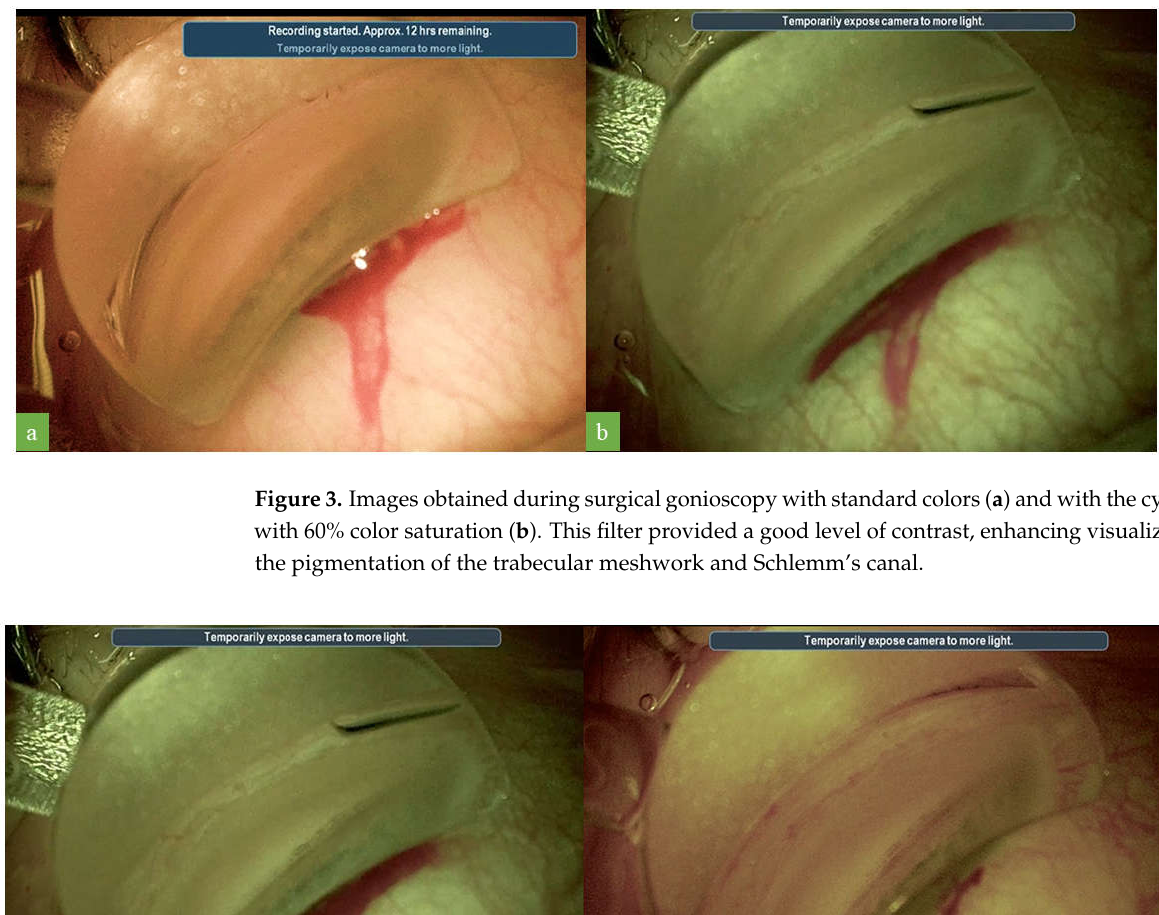
Figure 2. Standard colors gonioscopic images in three cases ( a – c ) and corresponding images after